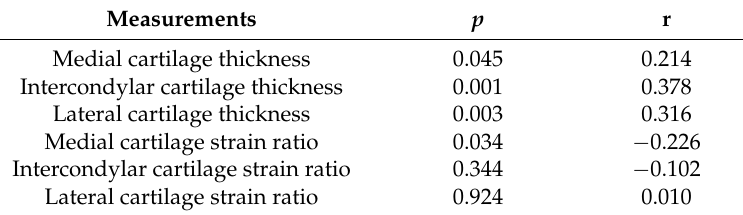
Table 4. Correlations between amount of smoking and sonographic